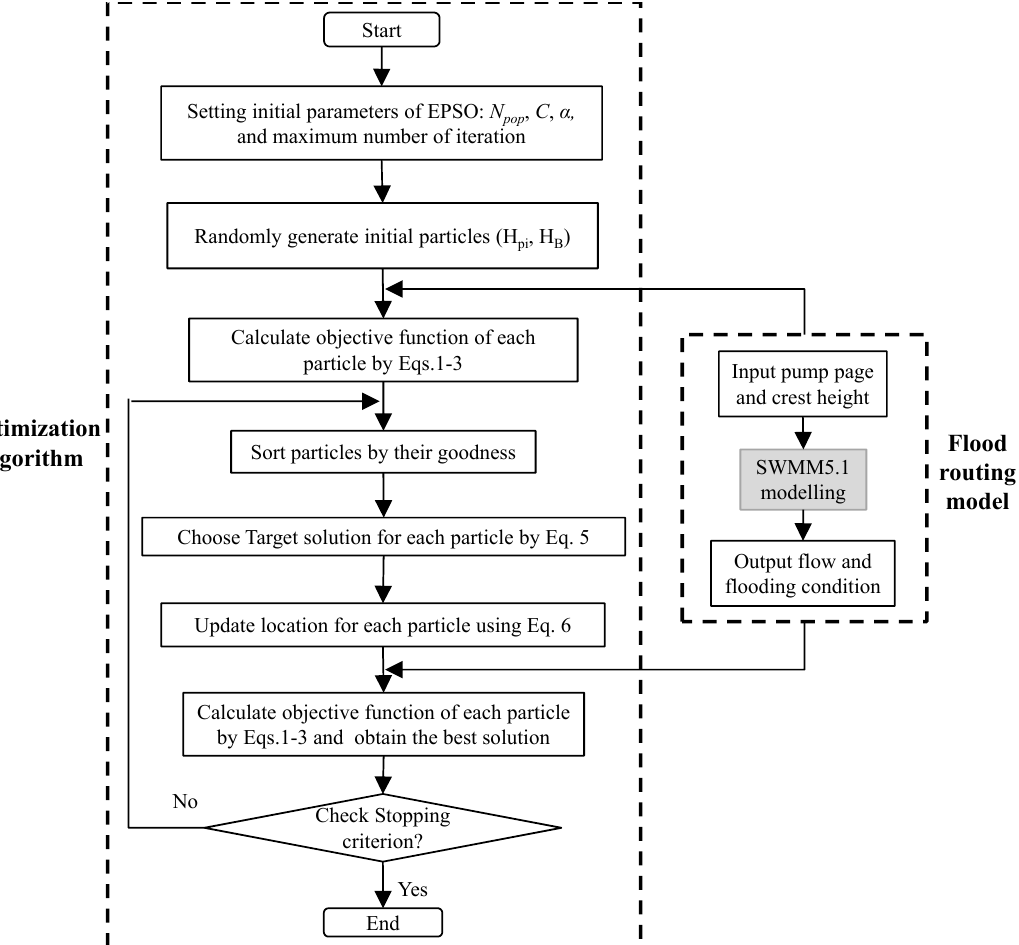
Figure 2. Flowchart of coupled model of EPSO and